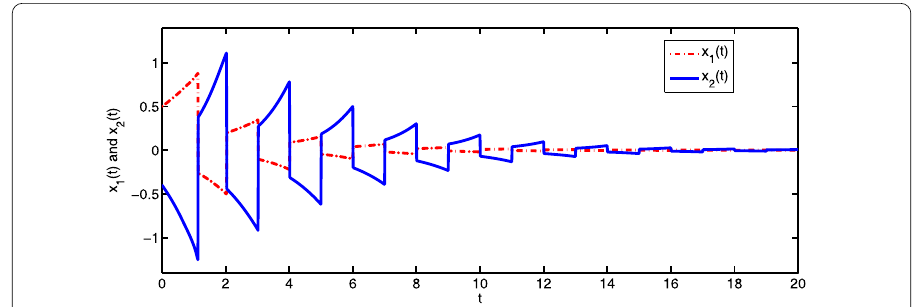
Figure 3 The time response curves of (17) in Example 2 with x (0) = (0.5 – 0.4) T